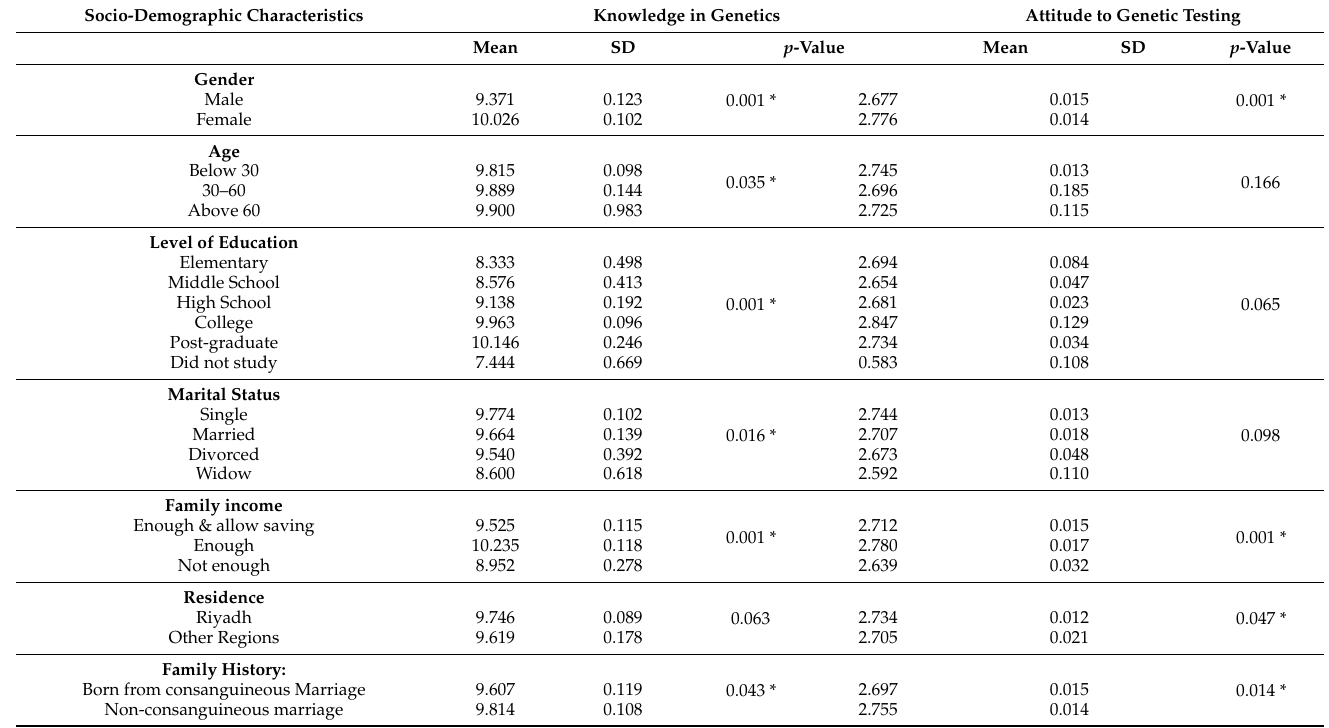
Table 4. Association Between Genetic Knowledge and Attitude Toward Genetic Testing with Demo- graphic Characteristics (N =